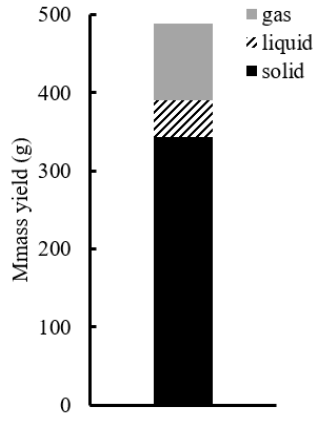
Figure 8. Mass balance of pyrolysis.